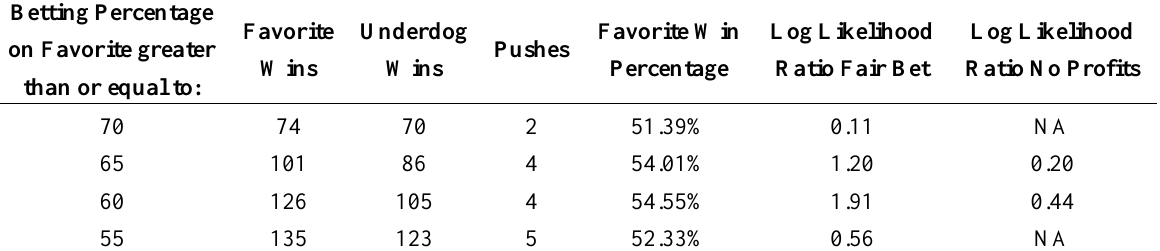
Table 7. Betting Simulations—Betting with the Public—Road